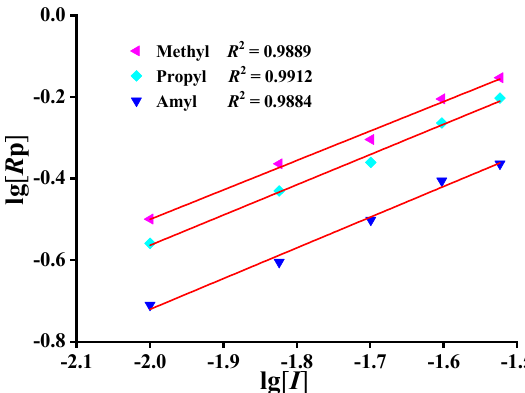
Figure 5. Relationship between lg R p and lg [ I ]. Table 4. Experimental results of fitting curve slopes of lg R p versus lg [ I ] of different monomers